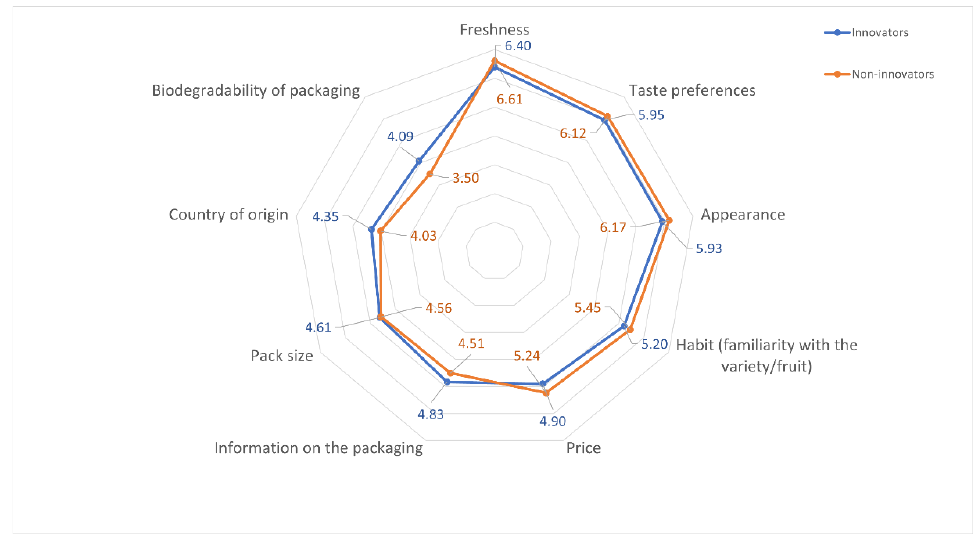
Figure 5. Significance (On a scale of 1–7: 1—definitely irrelevant factor; 7—definitely relevant factor) of selected features of fruits and fruit preserves for innovators and non-innovators.